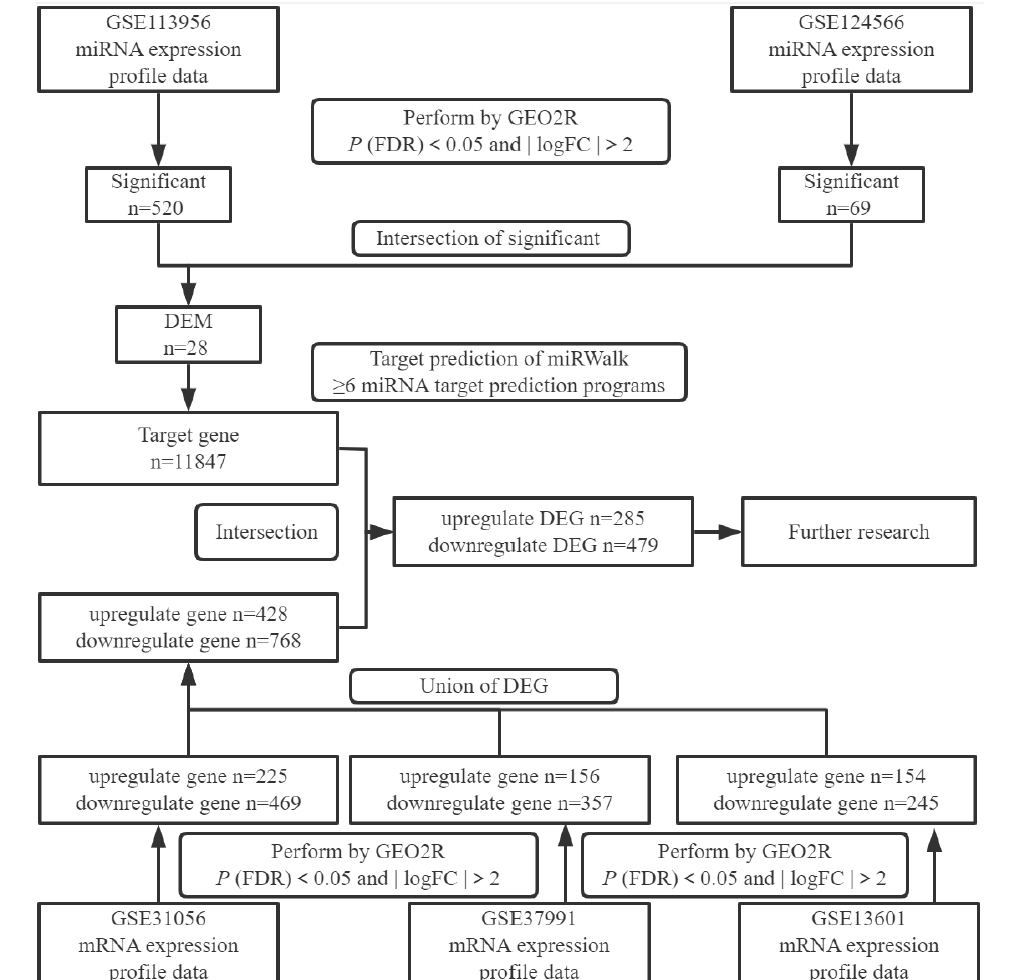
Fig. 1. Detailed screening process and conditions of DEMs and DEGs in